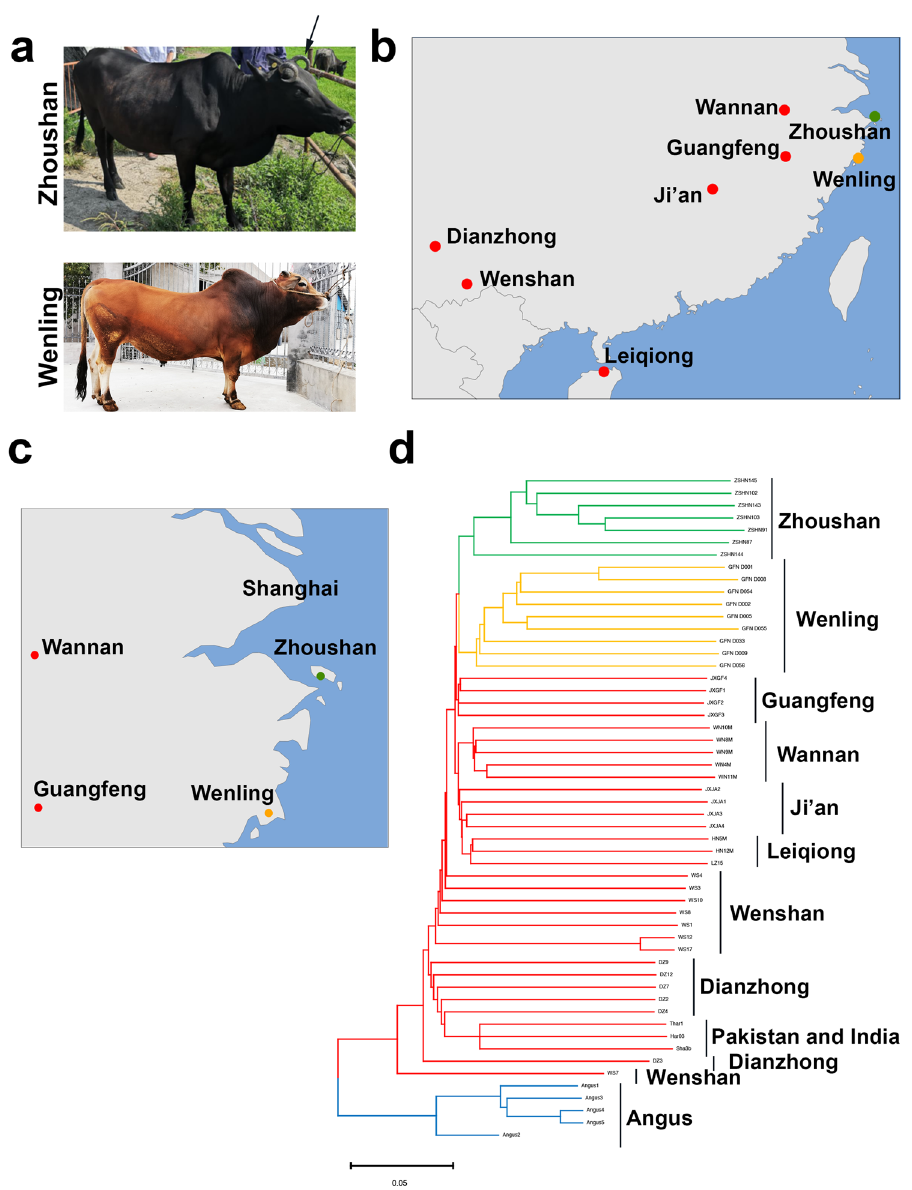
Figure 1. Phylogenetic analysis of Zhoushan cattle and other cattle breeds. ( a ) Gross appearance of Zhoushan (upper panel) and Wenling cattle (lower panel). Note that Zhoushan cattle have a dark black coat colour. The arrow indicates the curving horn of Zhoushan cattle. ( b ) Geographic map indicating the origins of Zhoushan (green dot) and Wenling (orange dot) cattle analysed in this study. We also examined other Chinese cattle (red dots) whose genome sequencing data were available. ( c ) Regional map around the Zhoushan islands. Wenling, Wannan, and Guangfeng are mainland regions close to the Zhoushan islands. ( d ) Neighbour-joining tree of the 54 domesticated cattle. The scale bar represents pairwise distances between different individuals. The maps were constructed by R 38 and R packages of maps v3.3.0 (https:// cran.r- proje ct. org/ web/ packa ges/ maps) and mapdata v2.3.0 (https:// cran.r- proje ct. org/ web/ packa ges/ mapda